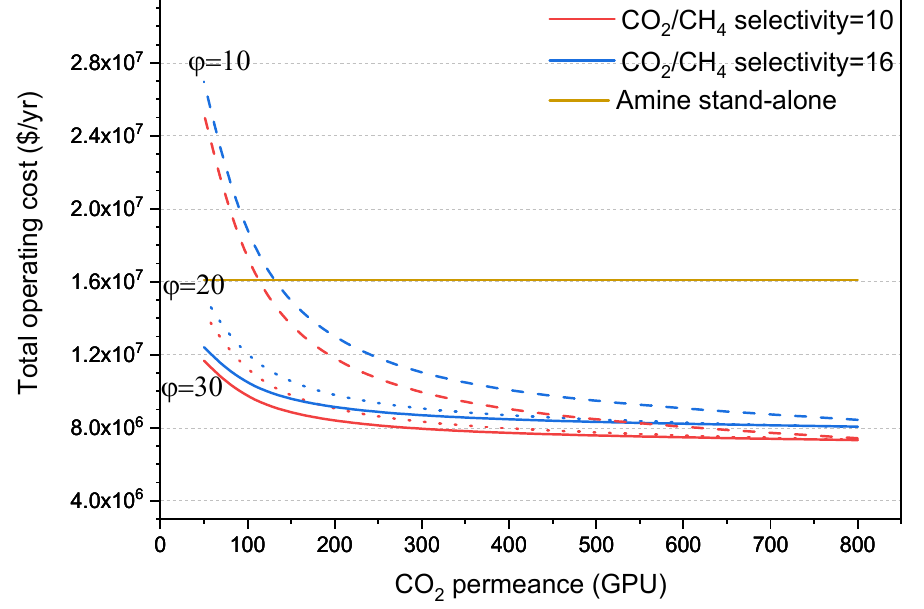
Figure 5. Effect of CO 2 permeance on the total annual capital operating cost of the hybrid process at CO 2 /CH 4 selectivity of 10 (red lines) and 16 (blue lines) and different pressure ratio values of 10 (dash lines), 20 (dot lines), and 30 (solid lines). The cost is compared to the operating cost of the stand-alone amine process (horizontal dark yellow line).